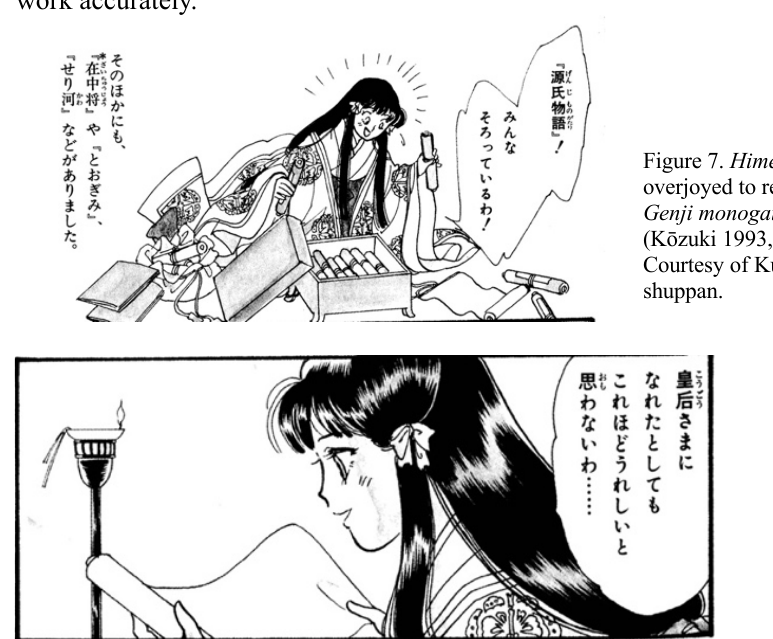
Figure 8. Hime feeling happier than an empress ( Kōzuki 1993, 61). Courtesy of Kumon shuppan.